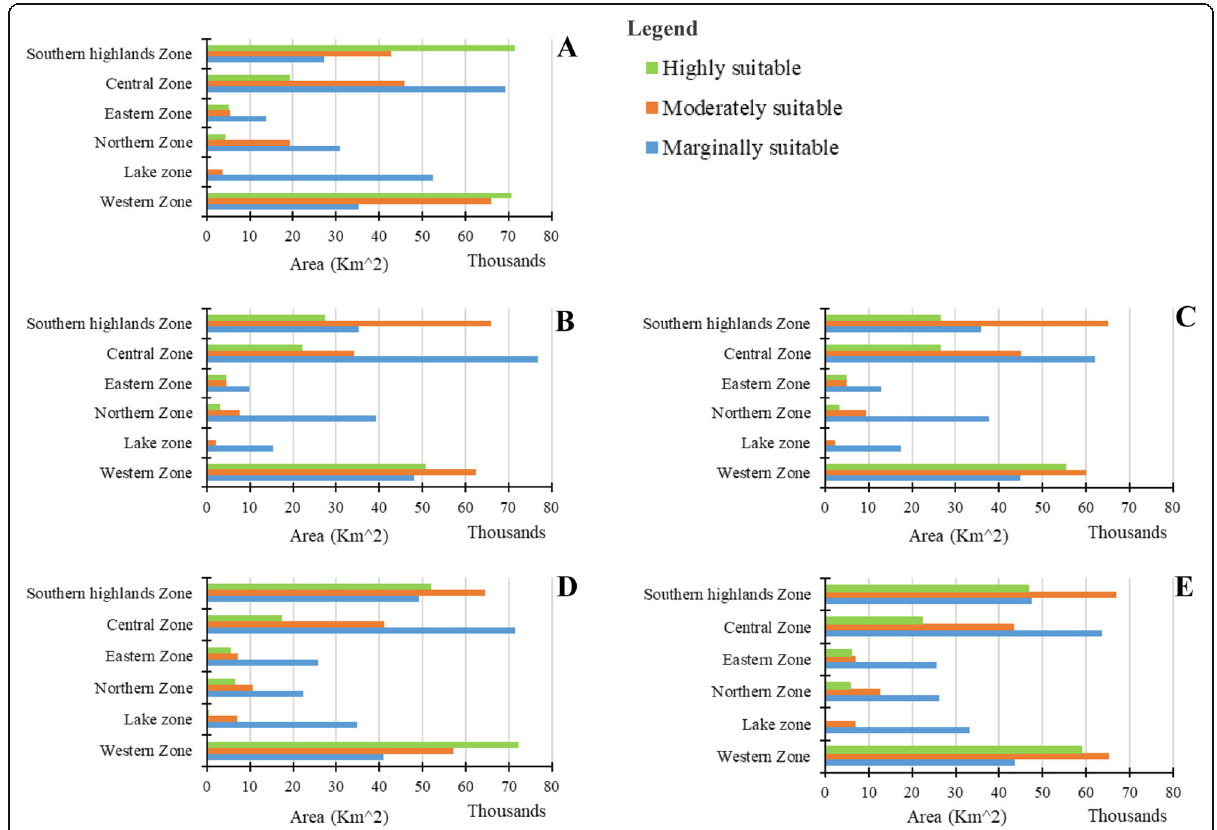
Fig. 4 Estimated potential area (km 2 ) areas for V. destructor by zones. a Current scenario. b Mid-century rcp4.5 scenario. c Mid-century rcp8.5 scenario. d Late-century rcp4.5 scenario. e Late-century rcp8.5